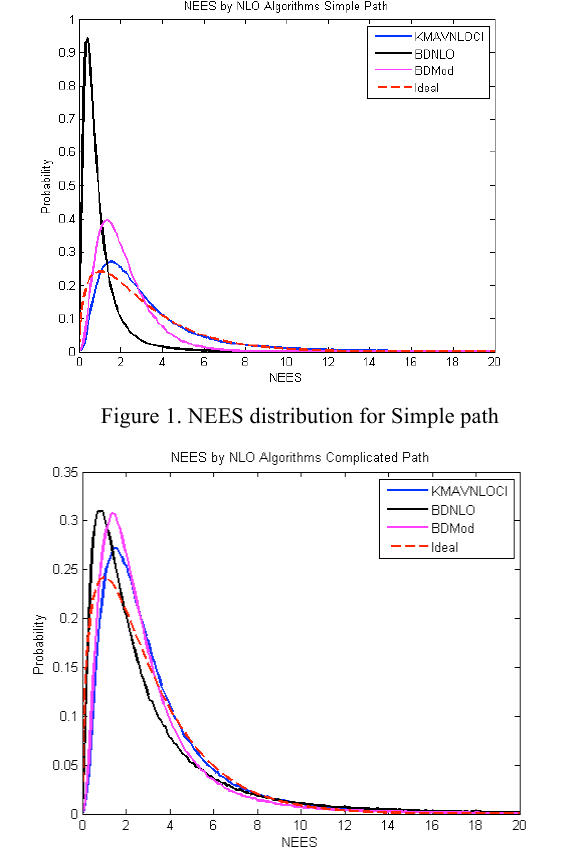
Figure 2. NEES distribution for a complicated